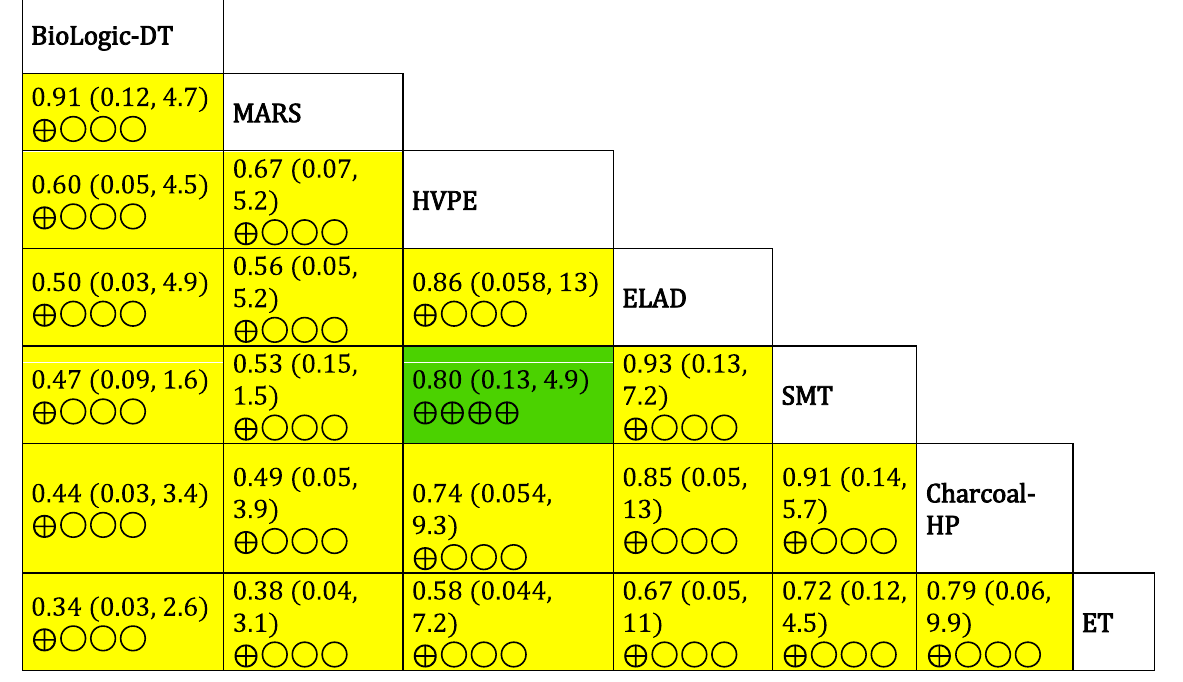
Table 2. League table of pairwise comparisons regarding in-hospital mortality. Values are given as relative risk (95% credible interval). The colour of the boxes indicates the comparisons’ overall risk of bias assessment (green: low risk of bias, yellow: some concerns, red: high risk of bias). The number of ⊕ symbols refer to the quality of evidence according to the GRADE approach ( ⊕ ⊕ ⊕ ⊕ high quality, ⊕ ⊕ ⊕ ◯ moderate quality, ⊕ ⊕ ◯◯ low quality, ⊕ ◯◯◯ very low